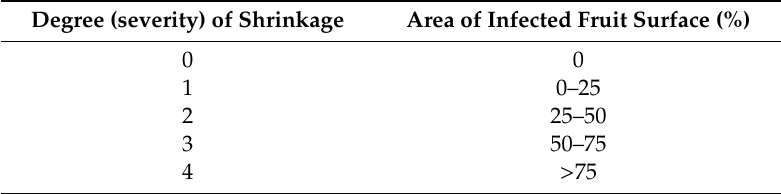
Table 1. Four-point systems used to evaluate the degree of passion fruit shrinkage. Degree (severity) of